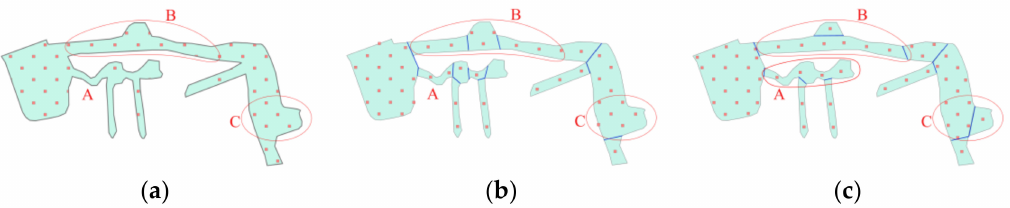
Figure 11. Complex area 3 (the blue solid line is the segmentation line). ( a ) Filling using the traditional three-square type method. ( b ) The effect of the filling method based on simple segmentation. ( c ) The effect of the method proposed in this